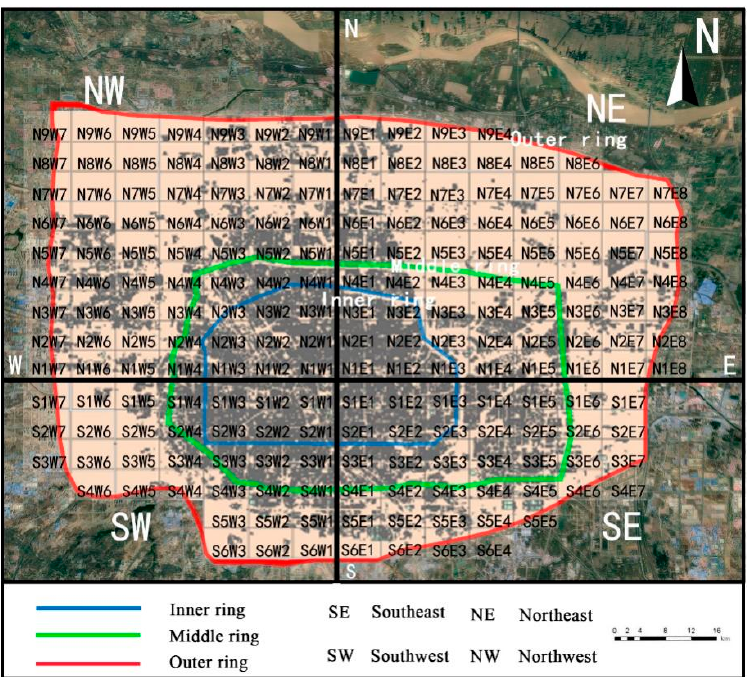
Figure 4. Gradient and grid division of the study area.